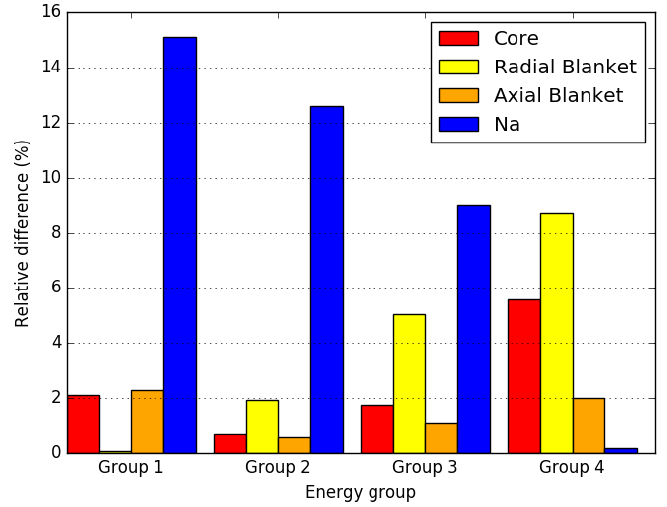
Figure 11. Comparison of region-averaged flux from reference and Parafish Model 2 Case 1.